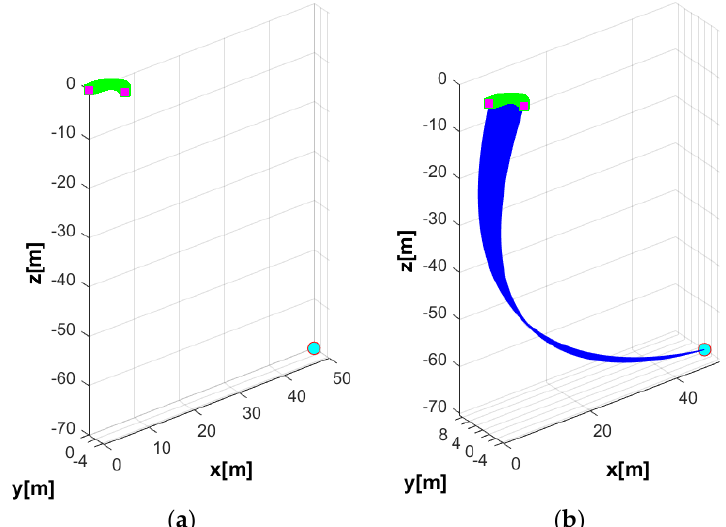
Figure 21. Trajectory of the complete systems: ( a ) trajectory of USV in the turning motion without the UC; ( b ) trajectory of USV in the turning motion with the UC.